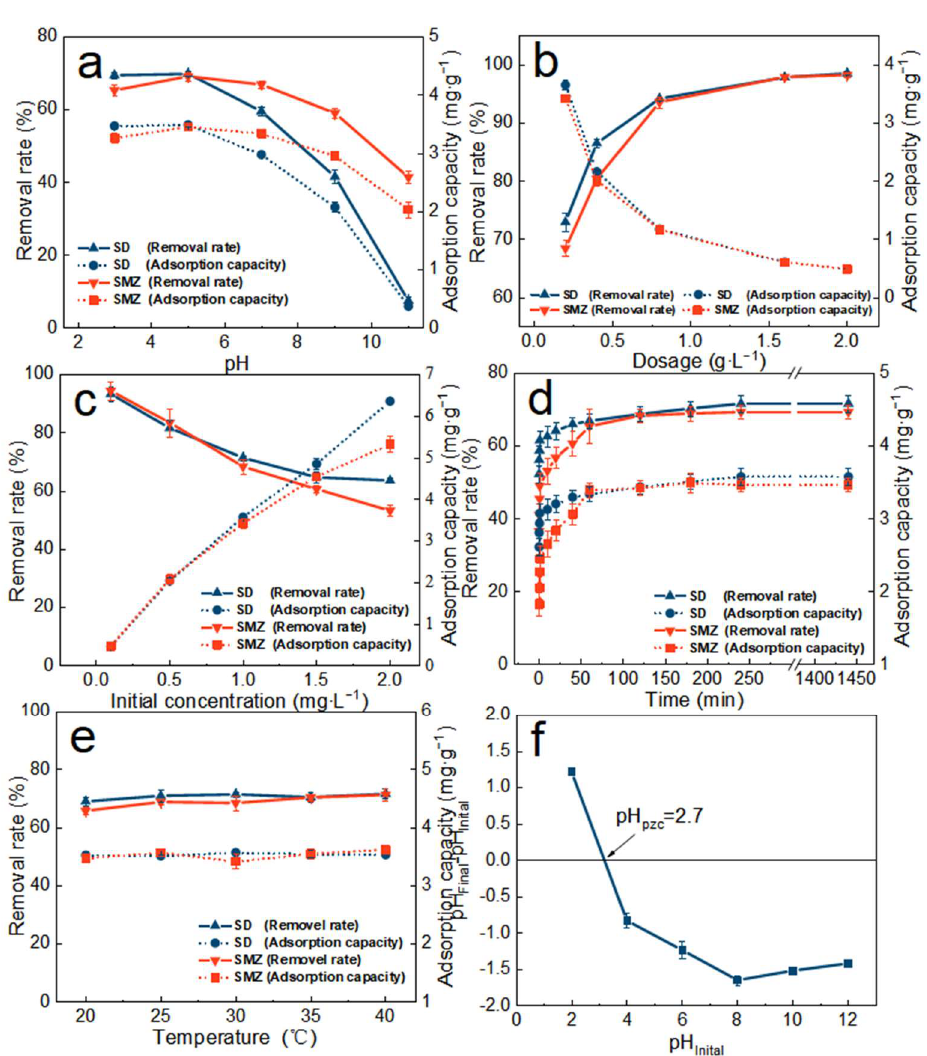
Figure 5. Effect of solution pH ( a ), adsorbent dosage ( b ), initial sulfonamides concentration ( c ), ad- sorption time ( d ), reaction temperature ( e ) on the adsorption of SD and SMZ by ATP/BC-0.1, and ( f ) measuring of the pH PZC of the ATP/BC-0.1.